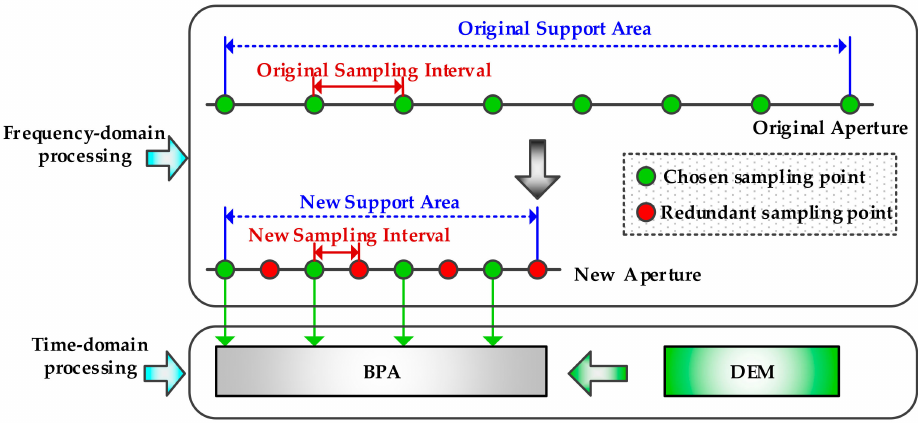
Figure 5. Illustration of proposed